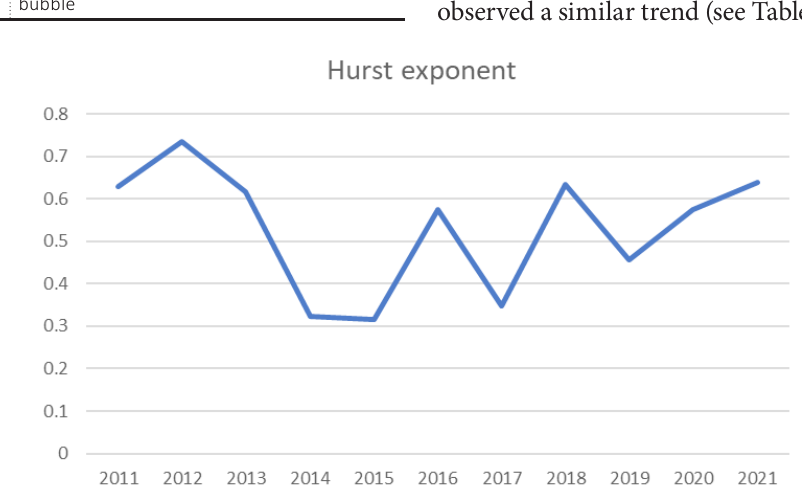
Figure 1. Hurst exponent values of BSE 100 from January 1, 2011 to December 31,